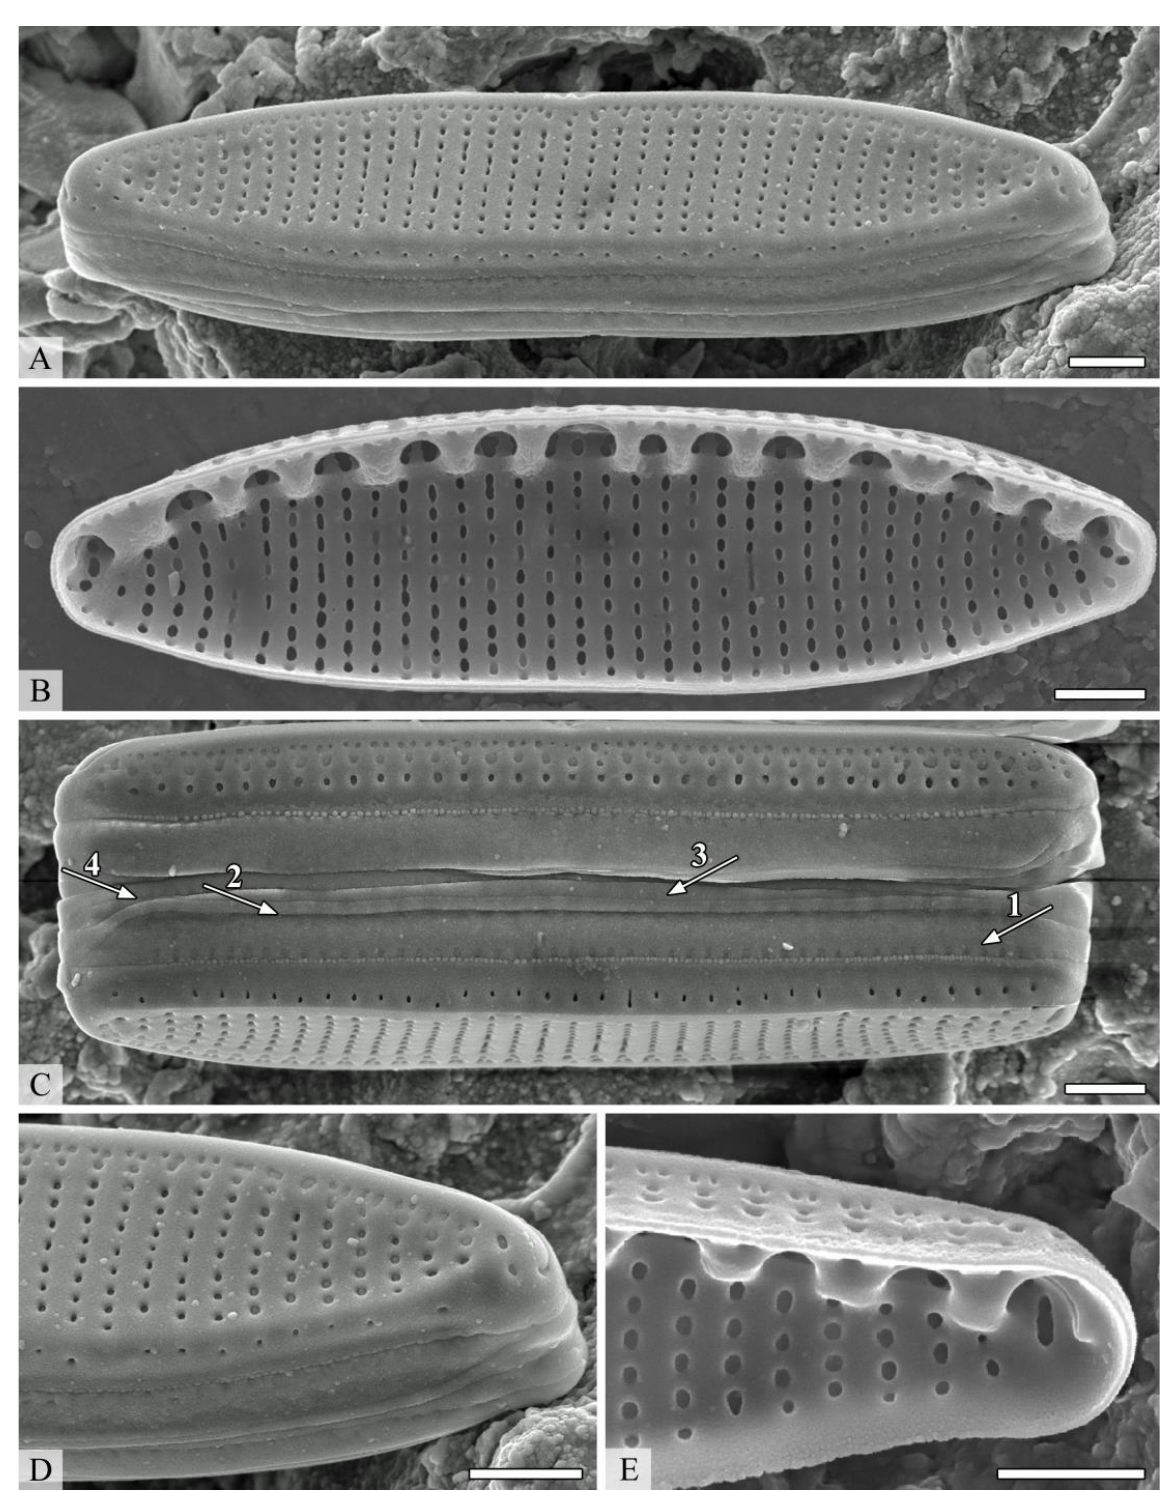
Figure 4. Cell ultrastructure of N. acidoclinata . ( A ) External valve view, ( B ) internal valve view, ( C ) girdle view of frustule showing the four open bands of the cingulum, ( D ) external view of the apex, ( E ) internal view of the apex. Scanning electron microscopy. Scale bars = 1 μm.